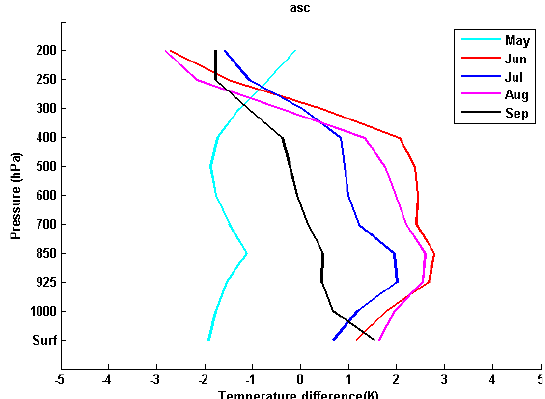
Fig. 10. The vertical structure of the monthly mean temperature anomalies during the summer months of year 2007. The remaining years (2003, 2004, 2005, 2006, and 2008) are used to calculate the monthly mean vertical temperature profiles. The data are averages over the entire study